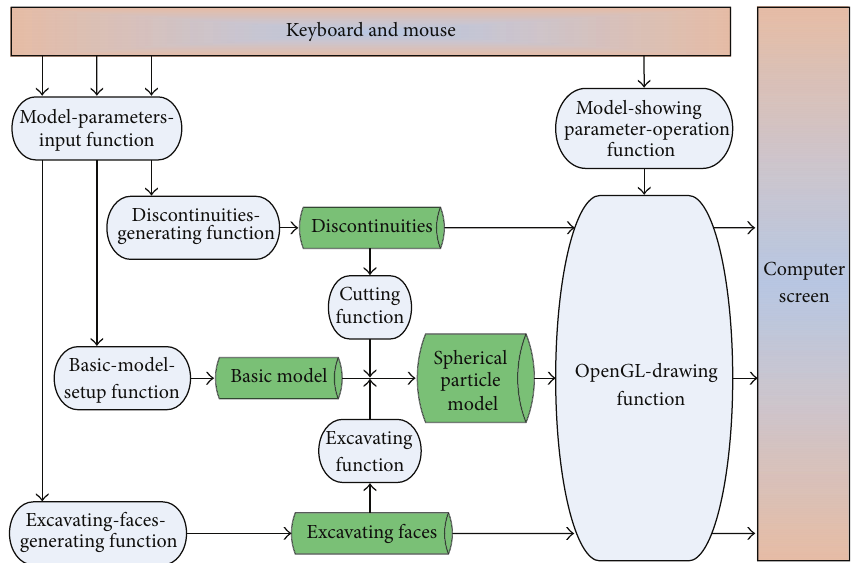
Figure 1: Program structure of the